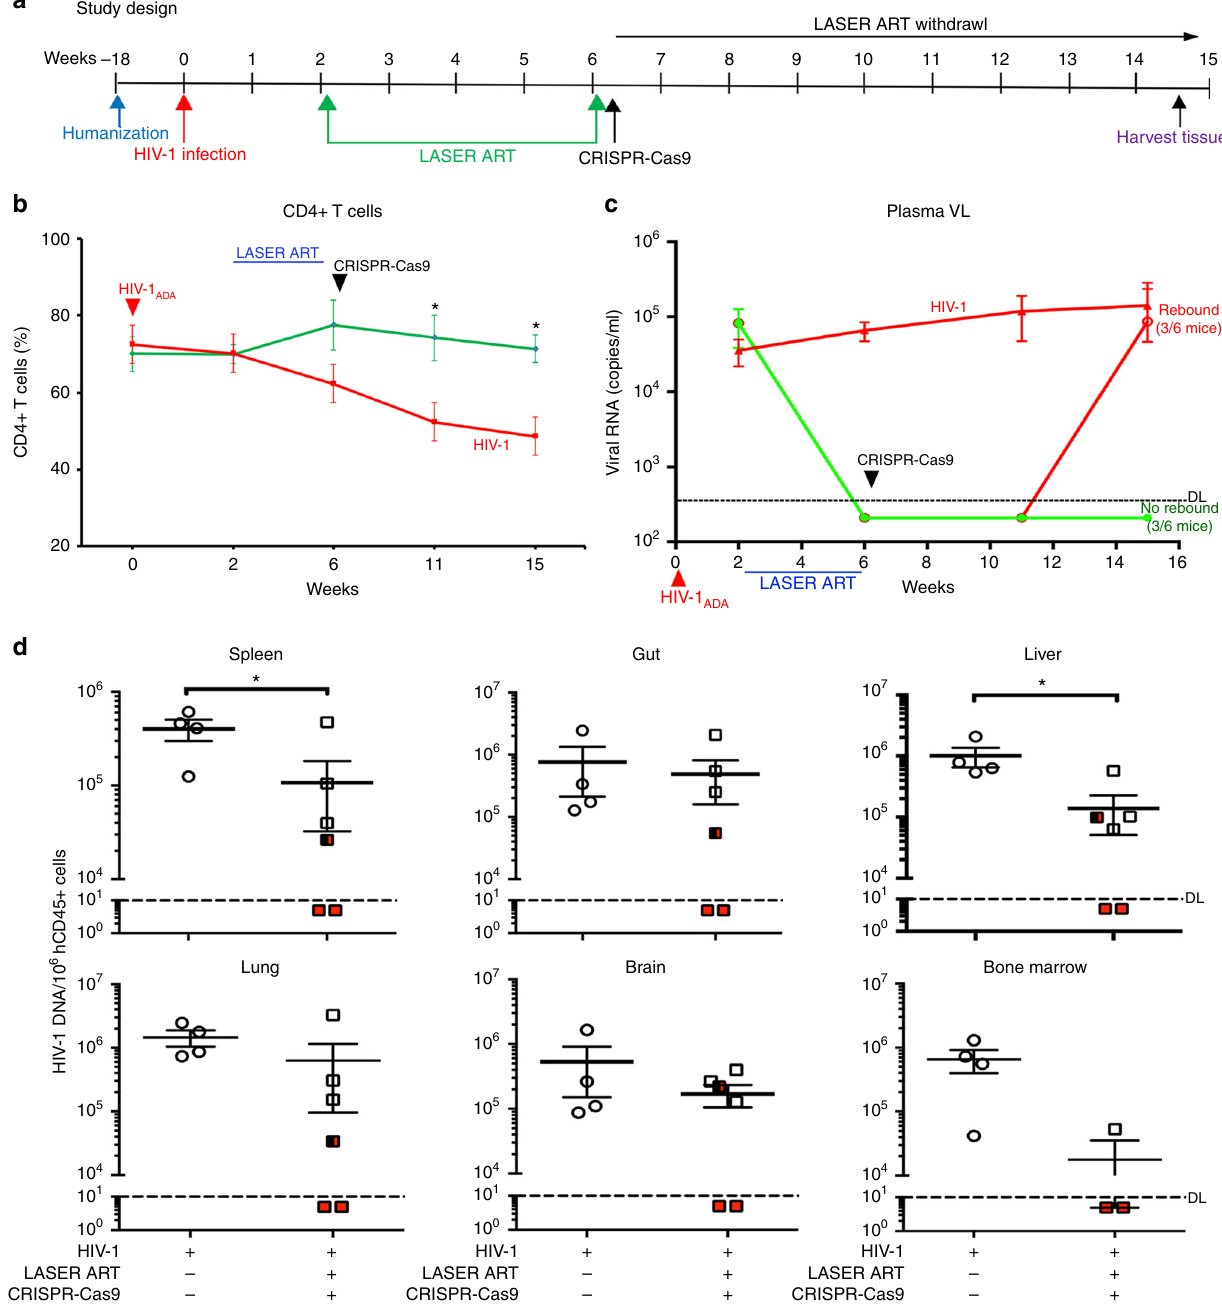
Fig. 7 Viral elimination in a subset of HIV-1 infected and treated humanized mice. Dual LASER ART and CRISPR-Cas9 treatment resulted in viral elimination in up to a third of HIV-1 ADA infected animals. Validation was made by state of the art viral, immune, and excision detection systems. a The timeline of the experiment showing the temporal administration of LASER ART and CRISPR-Cas9 treatments, and animal sacri fi ce. b The percentage of human CD4 + T cells and ( c ) viral loads measured in the HIV-1 infected ( n = 4, red). Dual treated animals ( n = 6, green) that showed no ( n = 3, green) or viral rebound ( n = 3, green to red) in plasma. d HIV-1 DNA analysis was performed using ultrasensitive semi-nested real-time qPCR assays from spleen, gut, liver, lung, brain and bone marrow from infected ( n = 4, open circles) and infected and dual-treated mice ( n = 6, squares). Whole bone marrowcells isolated from three animals (out of 6) from the dual-treated rebound group were used for adoptive transfer, Therefore, the data represent n = 3 for real-time-PCR assay for the dual-treated animals in the bone marrow adoptive transfer studies. The data are expressed as total HIV-1 DNA copies/10 6 human CD45 + cells. Two animals, M3319 and M3336 (illustrated by the red squares) were below the dashed lines for virus detection as measured by plasma VL. These animals had no detectable viral DNA after dual treatments demonstrating viral sterilization from all analyzed tissues. A single animal (M3324), as illustrated by a half-red-black designation, had an undetectable VL in plasma, but viral DNA was ampli fi ed in all the tissues analyzed. Source data are provided as a source data fi